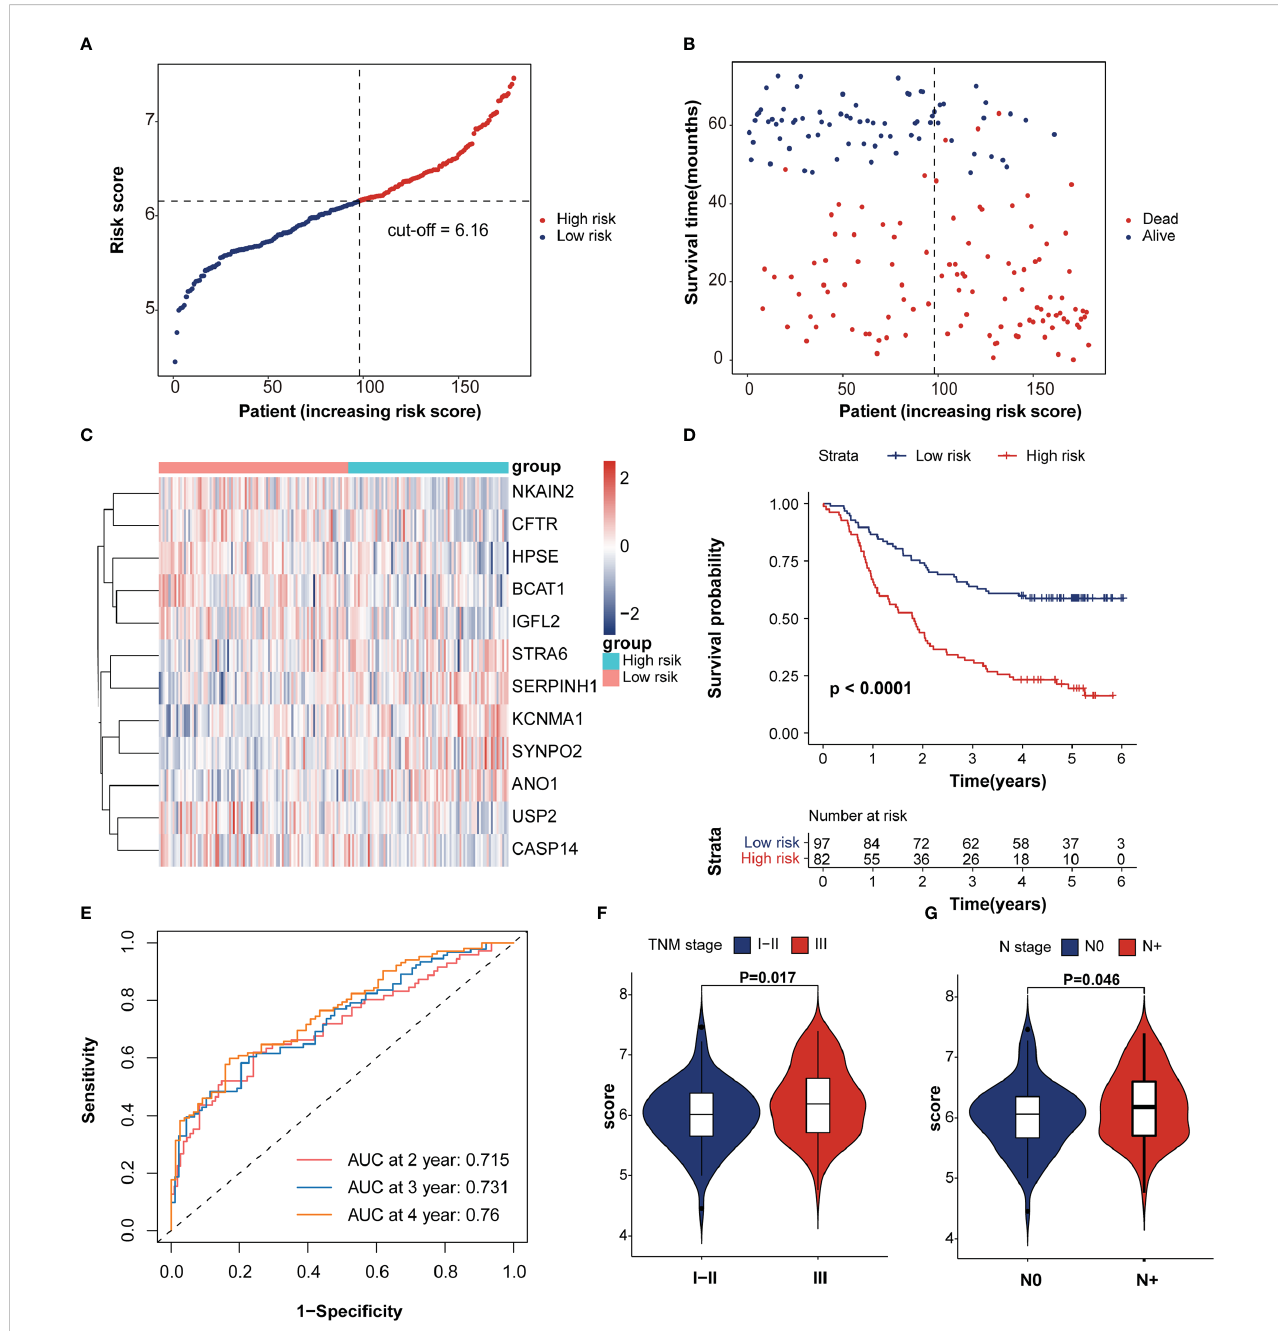
FIGURE 2 Survival analysis of immunotherapeutic response-related signature. (A) The rank of IRRS scores. (B) Survival status in the training cohort. (C) Heatmap of expression levels of twelve genes in the high- and low-score groups. (D) Kaplan – Meier curve of training cohort grouped by IRRS score. (E) Time- dependent ROC curve analysis of the prognostic model (2, 3, and 4 years). (F, G) The correction between IRRS score and patient ’ s clinicopathological stage, including T stage and TNM